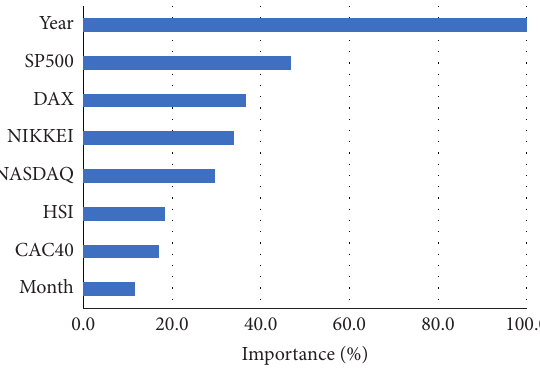
Figure 6: Importance analysis of the artificial neural